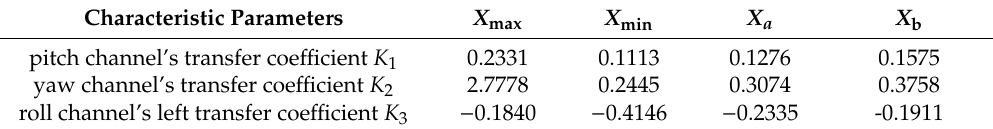
Table 4. The deterioration degree function parameters of the other three